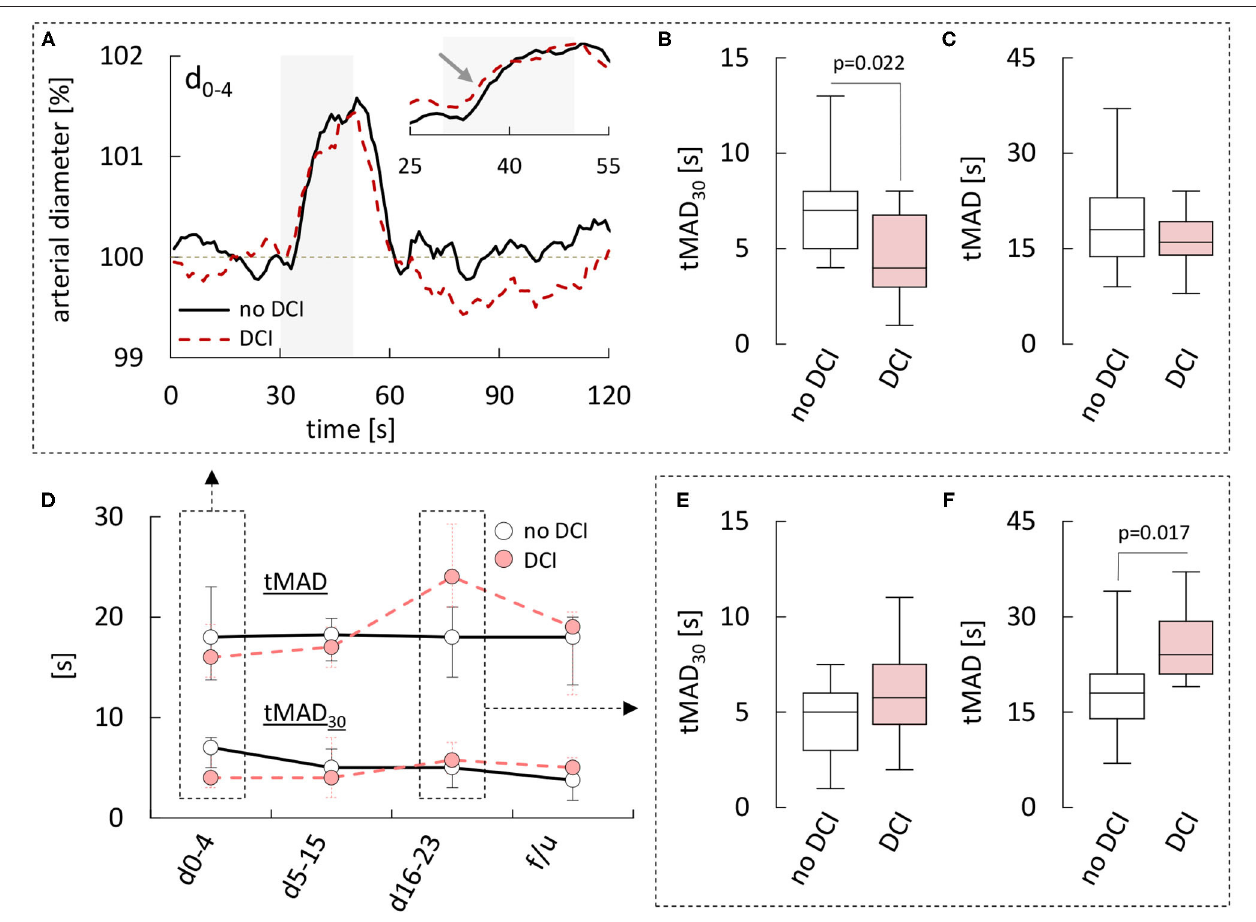
FIGURE 4 | Comparison of retinal arterial responses in aSAH patients with and without DCI. (A) Average relative retinal arterial responses to flicker light stimulation measured during the early phase (days 0–4) in aSAH patients with or without delayed cerebral ischemia (DCI). Stimulation period is indicated by light gray shading. Inset shows the rising phase on an expanded time-scale and after scaling the responses to the same amplitude to highlight kinetic changes. (B) Time to 30% of the maximum arterial dilation (tMAD 30 ) and (C) time to maximum arterial dilation (tMAD) determined during the early phase in patients with and without DCI. (D) Time-course of changes in median [q1–q3] tMAD 30 (bottom) and tMAD (top) observed in patients with or without DCI. (E) tMAD 30 and (F) tMAD determined during the late phase (days 16–23) in patients with and without DCI. For a summary of all parameters and p -values see Supplementary Table 2